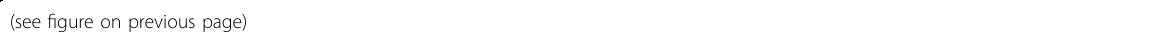
Fig. 4 Acetate-induced suppression of the NLRP3 in fl ammasome is mediated by GPR43-G q/11 -Ca 2 + . a , b Acetate-induced suppression of the NLRP3 in fl ammasome is dependent on GPR43. ELISA of siRNA interference for GPR43 but not GPR41 ( a ) in LPS-primed BMDMs pretreated with acetate for 30 min ( n = 6). ELISA showing the effect of a GPR43 agonist on IL-1 β production ( b ) ( n = 3). c , d Acetate-induced suppression of the NLRP3 in fl ammasome requires the G q/11 subunit rather than the G I/O subunit. ELISA of IL-1 β in G I/O subunit inhibitor-treated ( c ) and G q/11 subunit siRNA knockdown ( d ) LPS-primed BMDMs ( n = 6). e , f Fluorescence change of F max and F 0 and representative curve of calcium changes in PMs with or without treatment with 2-APB ( n = 4). g Chelation of Ca 2 + (BAPTA) reversed the suppressive effects of acetate on IL-1 β production ( n = 3). h cAMP levels measured by ELISA were decreased by acetate in LPS + Nig-treated BMDMs ( n = 3). n = biological replicates. Data are presented as the mean ± SEM. * P < 0.05, ** P < 0.01, *** P < 0.001, and **** P < 0.0001, Student ’ s t- test compared with the control